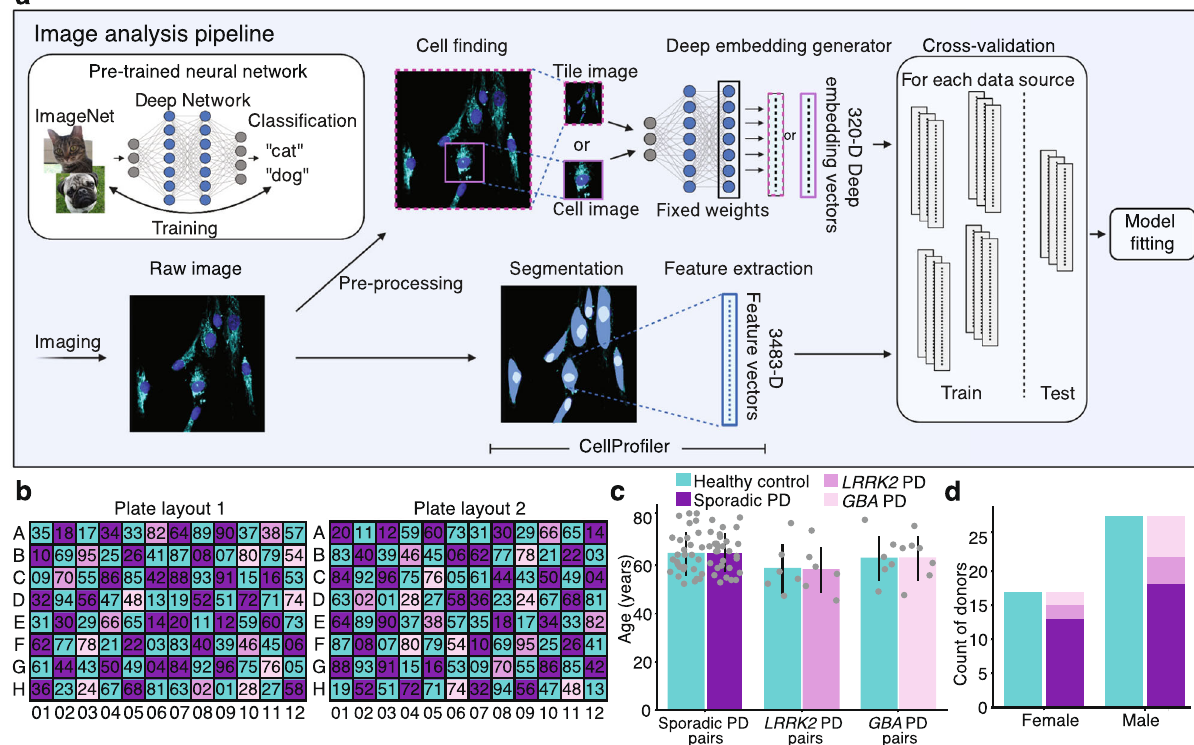
Fig. 2 Image analysis pipeline and rigorous experimental design enable unbiased deep learning – based high-content screening. a A deep embedding generator (a neural network pre-trained on an independent object recognition task) maps each tile or cell image independently to a deep embedding vector, which along with CellPro fi ler features and basic image statistics were used as data sources for model fi tting and evaluation for supervised learning prediction tasks including healthy vs. PD classi fi cation. b Two 96-well plate layouts used in each experimental batch control for location biases. In each layout, each well contained cells from one cell line denoted by the two-digit label. The second layout consisted of diagonally translating each of the four quadrants of the fi rst. n = 45 healthy controls and n = 45 PD patients were matched in pairs based on demographics, including by c age and d sex. Data are presented as mean values ± standard